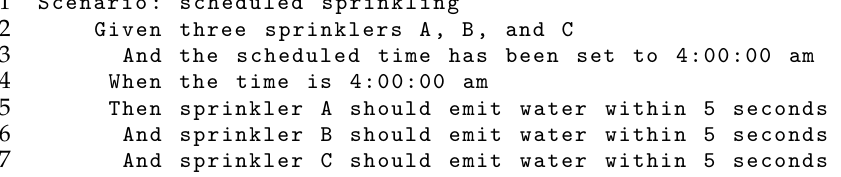
Figure 3. Lift operations: safety over serving normal requests in case of an emergency executed, sprinkler A and sprinkler C should fail to emit water within 5 seconds (line 5 and line 7) whereas sprinkler B should emit water normally (line 6).